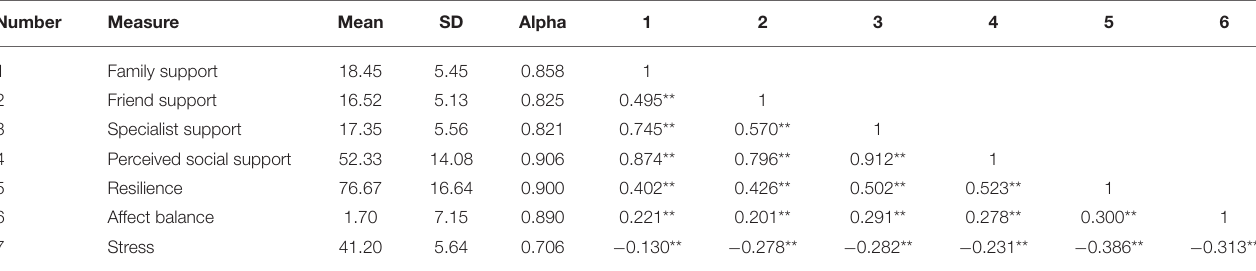
TABLE 2 | Means, standard deviations (SD), reliabilities and inter-correlations among study variables.